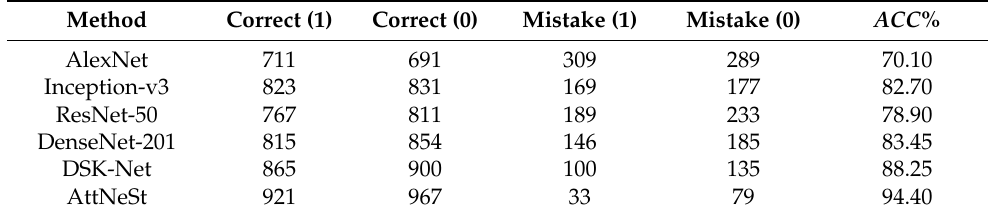
Table 8. Results of image category